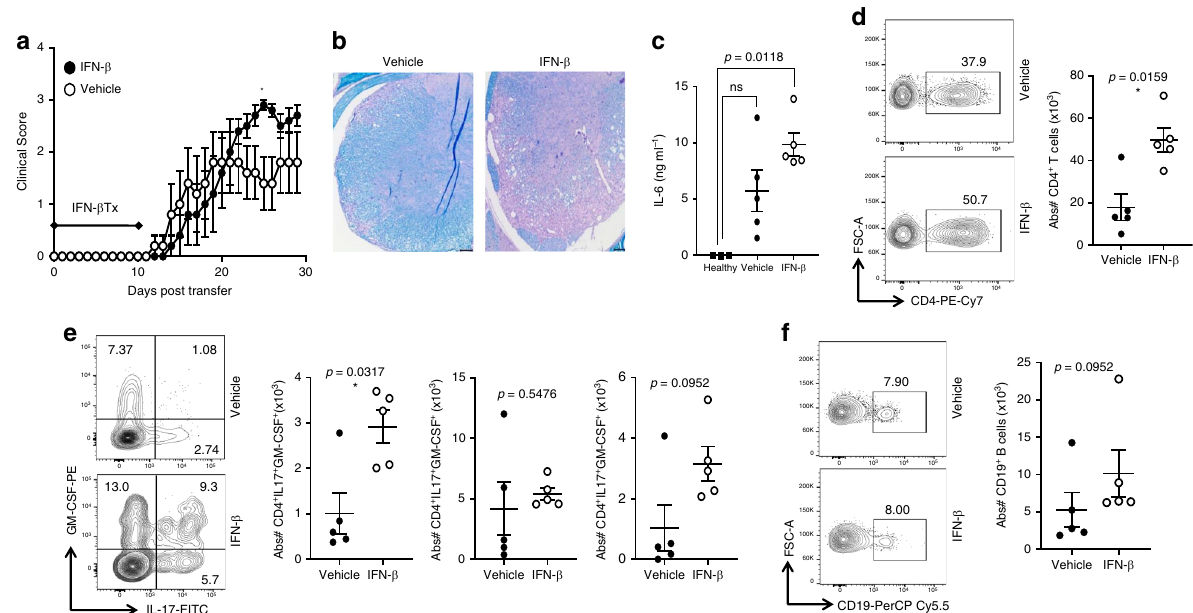
Fig. 6 IFN- β elevates IL-6 and exacerbates TH17-driven EAE. MOG-primed TH17 cells were transferred into recipient mice and treated with 1000 U of IFN- β or vehicle every other day from day 0 – 10 post transfer of cells. a Clinical scores of mice with TH17-EAE treated with vehicle or IFN- β ; (TH17-vehicle n = 5, TH17-IFN- β n = 5) and two-tailed Mann – Whitney tests were performed to determine statistical signi fi cance (* P < 0.05). Representative of four experiments with similar results. b Spinal cord sections from mice (day 30) were stained with H&E and Luxol fast blue. Representative images of four mice in each group. Scale bar represents 100 µ m. c Levels of IL-6 in the sera (measured by ELISA) of TH17-EAE (day 2) were elevated with IFN- β ; (TH17-vehicle n = 5, TH17-IFN- β n = 5, healthy n = 3) and a two-tailed Kruskal – Wallis test with multiple comparisons corrected by the Dunn ’ s method was used